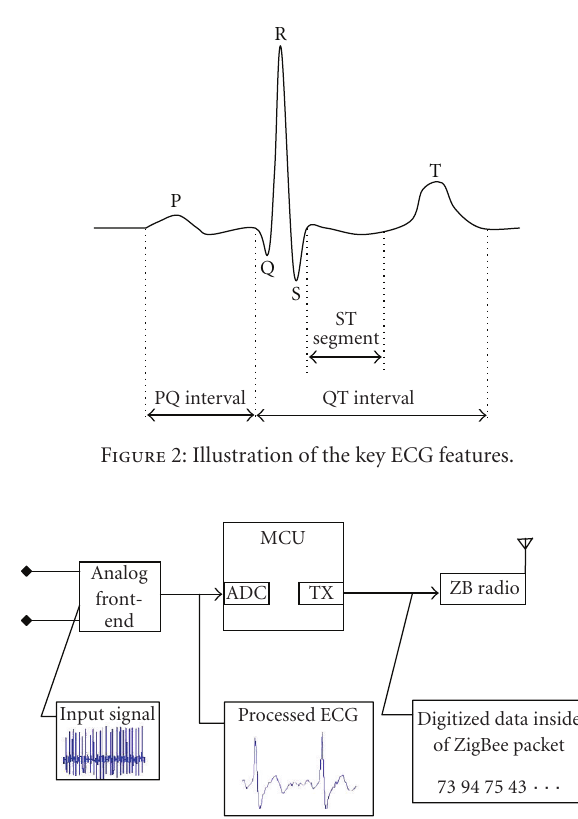
Figure 3: Block diagram of the ECG measurement platform.